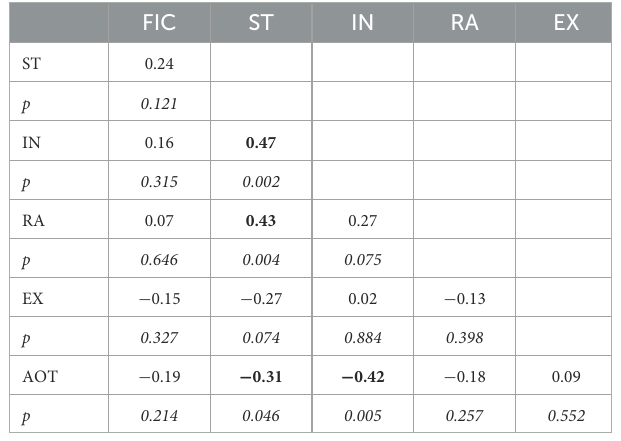
TABLE 1 Experiment 1: correlations between FIC and scores of risk-style (stimulating and instrumental risk) and cognitive-style (rational thinking, experiential thinking, and actively open-minded thinking